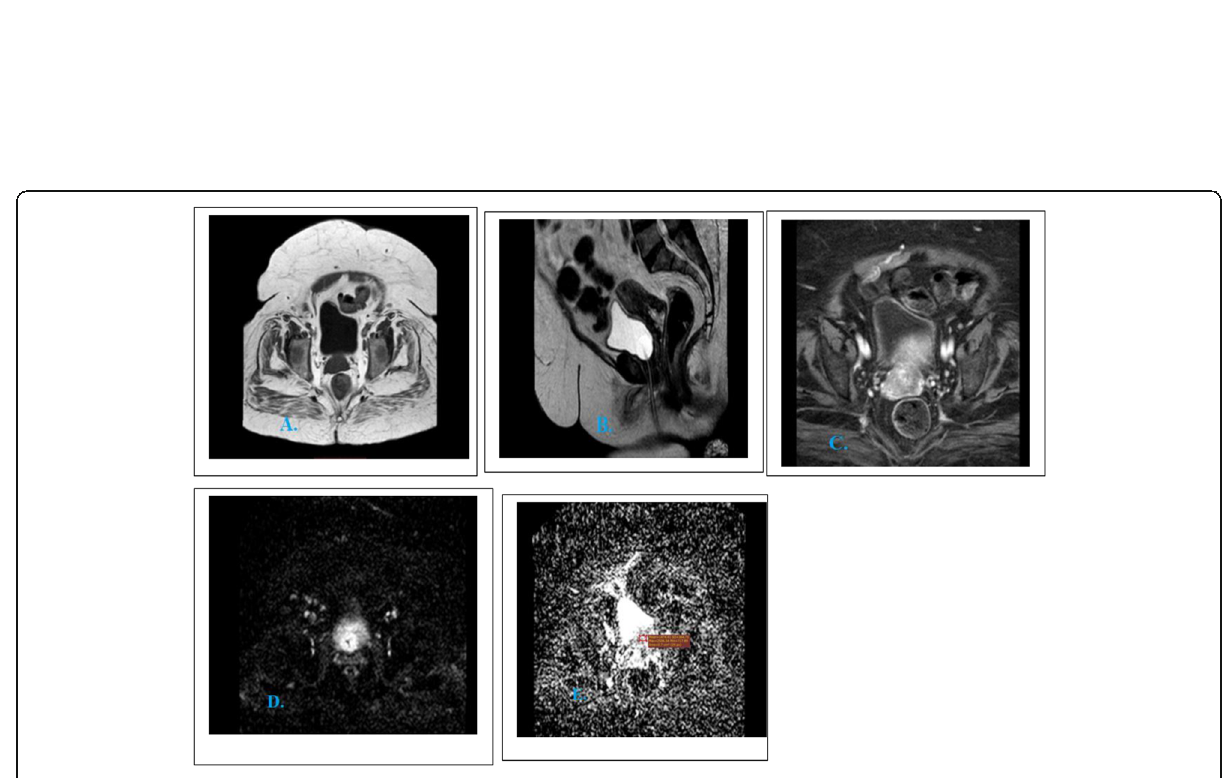
Fig. 3 Seventy-year-old female patient presenting with post-menopausal bleeding. a – c Axial T1WI, sagittal T2WI and post-contrast axial image revealed the presence of enhancing soft tissue lesion distended the cervical canal with intact surrounding serosa, measuring 2 × 2 × 3 cm in (AP, transverse, CC) dimensions, low signal intensity on T1 and high signal intensity on T2, post-contrast heterogeneous enhancement. High signal on DWI ( d ), and high signal on the corresponding ADC maps ( e ). ADC value was (1.474 × 10 − 3 mm 2 /s). Finding suggestive of benign lesion. Pathology revealed: chronic